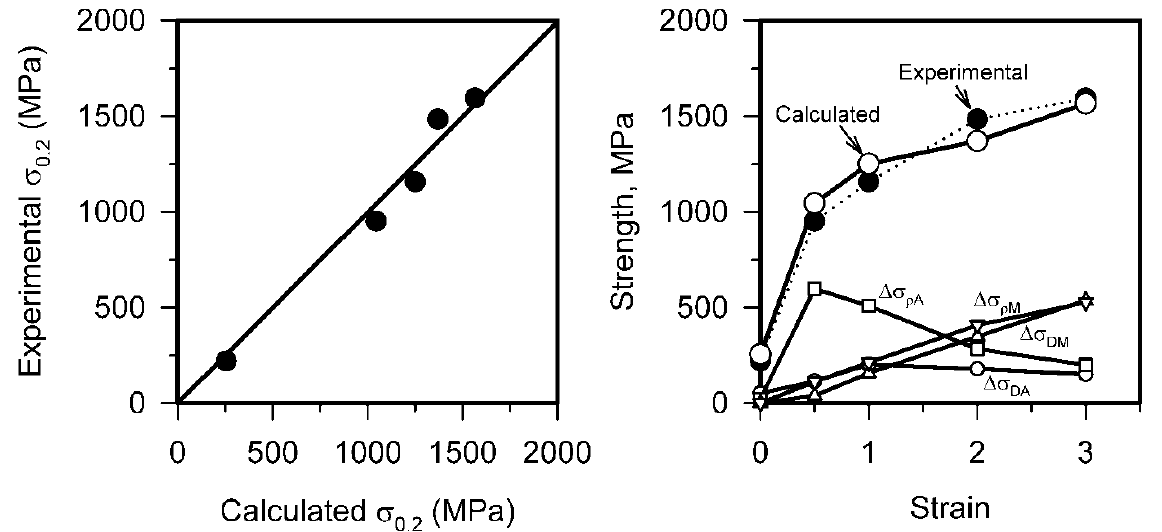
Figure 8. The relationship between experimental and calculated yield strength (σ 0.2 ) and the contribution of grain size strengthening (∆σ D ) and dislocation strengthening (∆σ ρ ) into overall strength on a 304L stainless steel subjected to cold rolling. The indexes of A and M indicate the austenite and martensite,